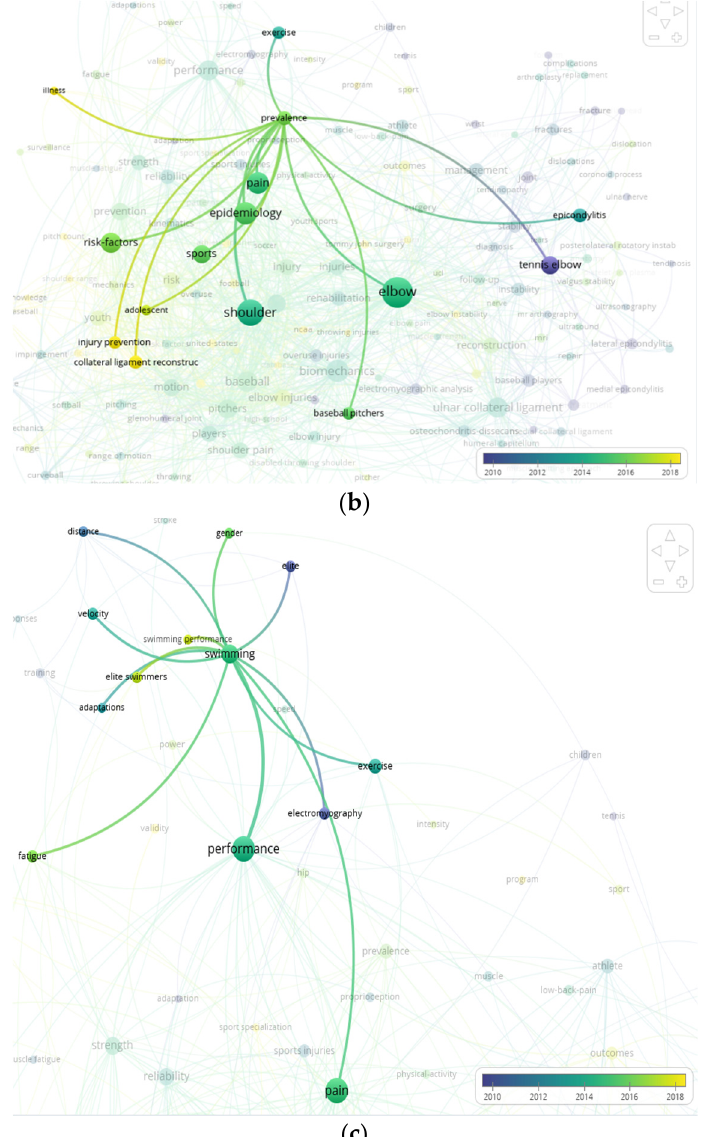
Figure 6. Analysis of themes. ( a ) Network map of trending topics according to the keywords applied from 2010 to 2018. The indicator shows recent publications from green to yellow. More studies focusing on knowledge, pitch count, risk factor, elite swimming, and the prevalence of elbow matters have been published recently. The size of the circles represents the frequency of appearance as keywords. The distance between two circles indicates their correlation. ( b , c ) The trend topic of prevalence applied from 2010 to 2018. The indicator shows recent publications from green to yellow. The size of circles represents the frequency of appearance as keywords. The distance between two circles indicates their correlation.